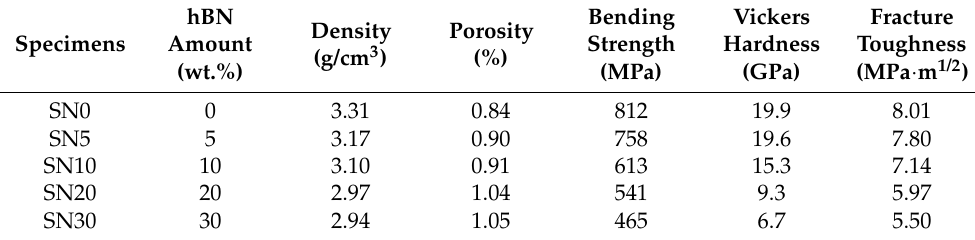
Figure 2. Schematic diagram of a pin-on-disc tester.